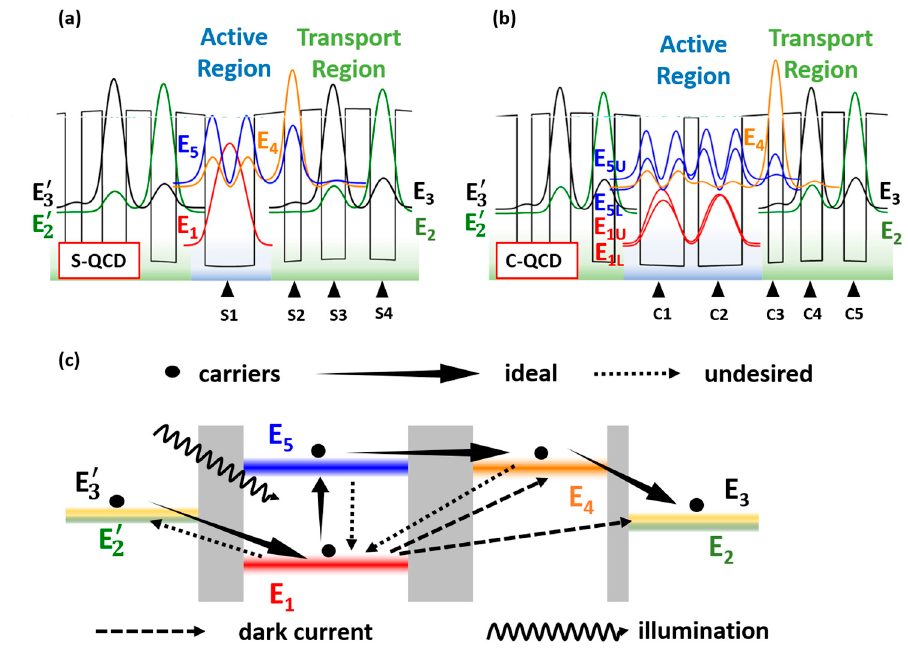
Table 1. Energy separations in the two QCD devices.